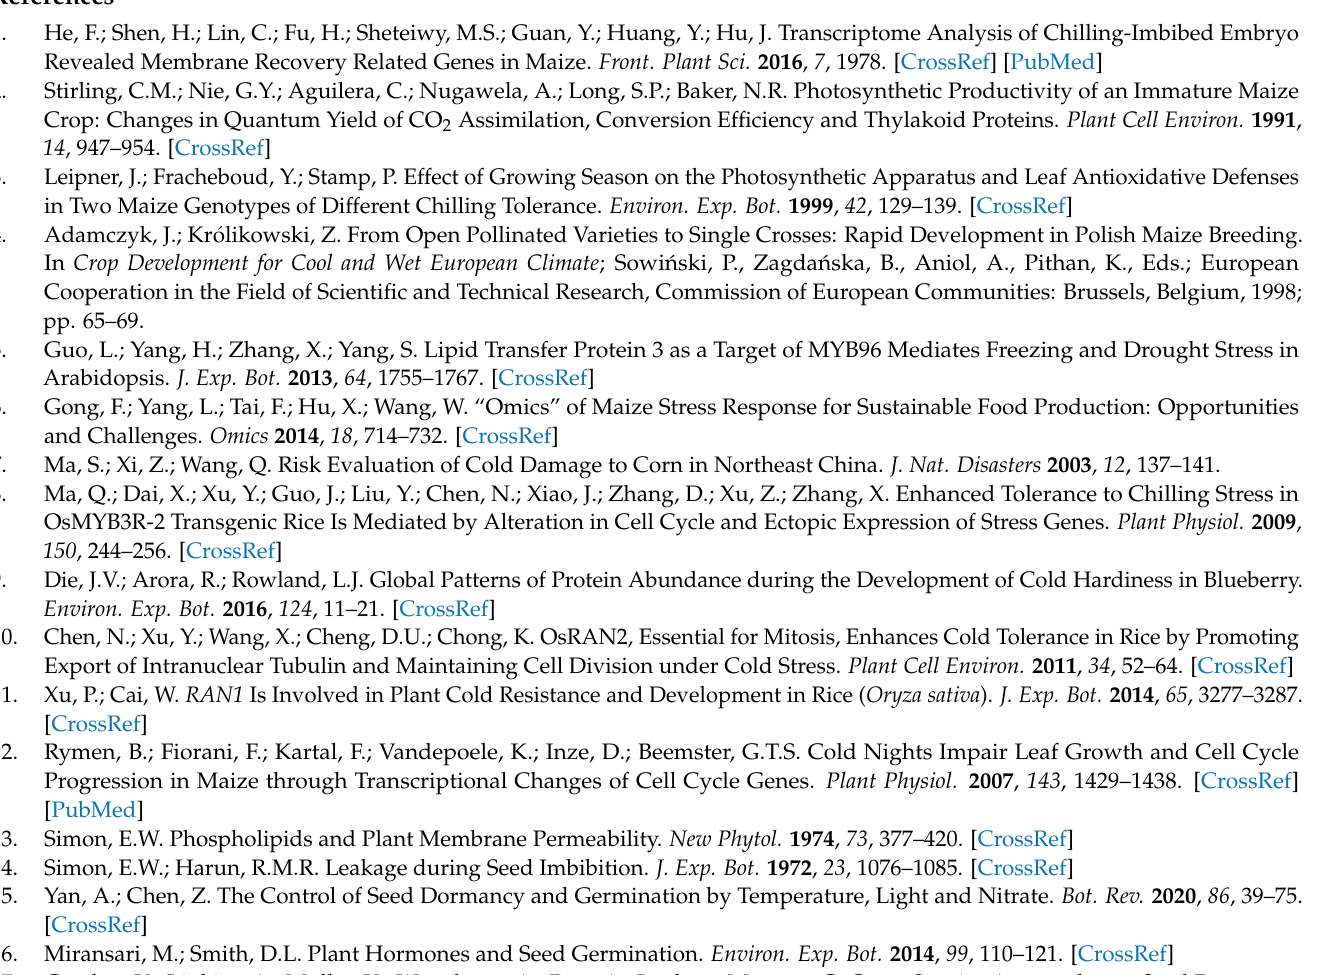
Table S3. Plasma membrane associated GO categories enriched from the L220 specifically down- regulated LTGA DEGs; Table S4. Plasma membrane associated L220 specifically down-regulated LTGA DEGs; Table S5. Significant GO categories for NIL 220-3 specifically expressed DEGs; Table S6. Significant GO categories for NIL 220-25 specifically expressed DEGs; Table S7. The annotation of the 27 common tolerant specific DEGs in MaizeGDB database; Table S8. Primers used in this